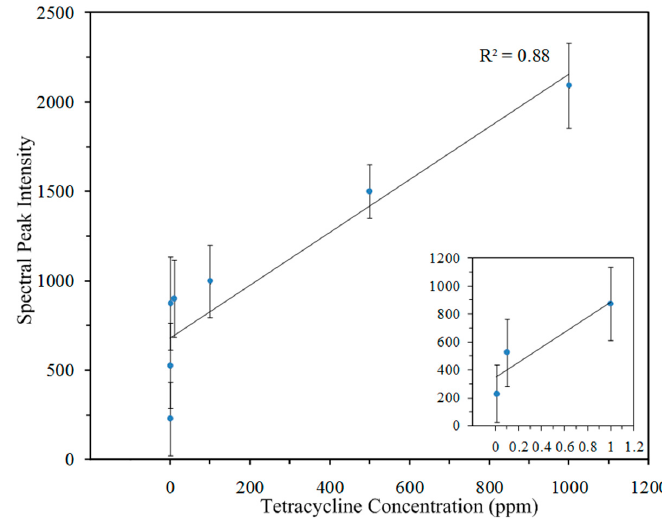
Figure 8. Linear relationship between tetracycline peak intensity at 1322 cm − 1 and its concentration in milk. Inset: 0.01 ppm, 0.1 ppm and 1 ppm.